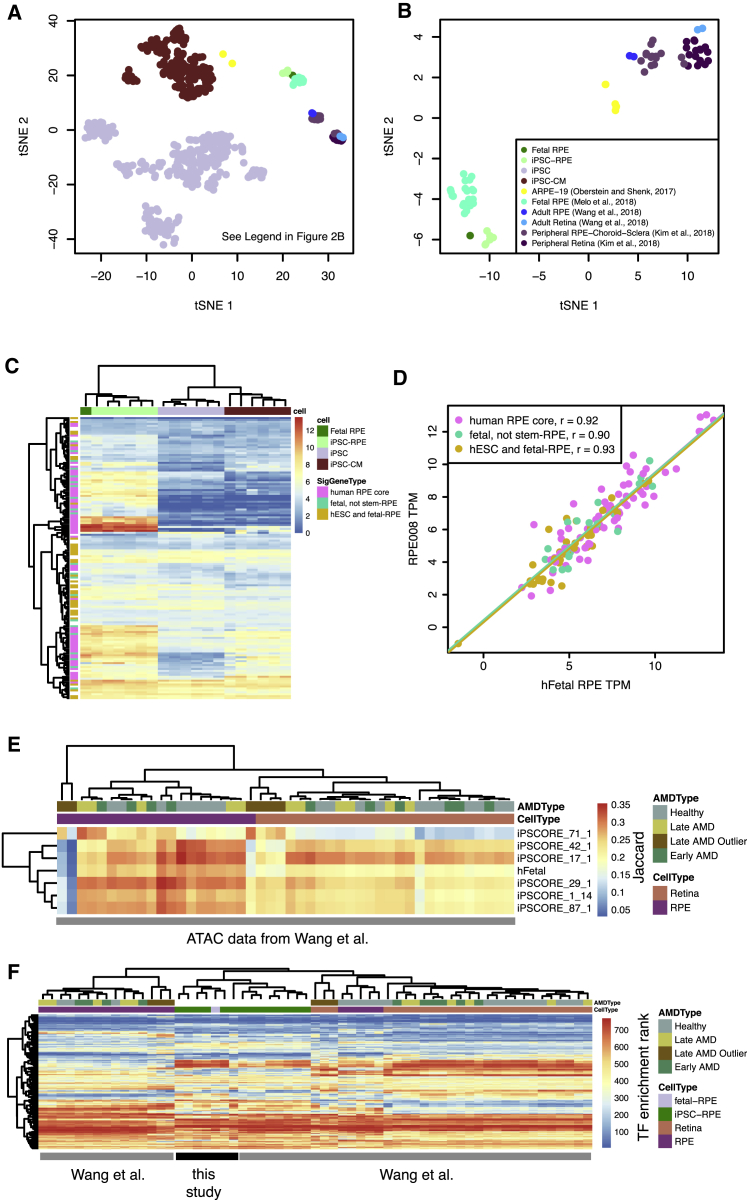
Gene Expression and Chromatin Accessibility of iPSC-RPE and Other Eye Samples(A) tSNE plot based on the first 30 principal components of RNA-seq using 10,000 of the most variable genes. Samples include iPSCs, iPSC-CMs, iPSC-RPE, and fetal RPE data generated for this paper, and RPE and retina samples from external public data sources (see legend in B, inset).(B) tSNE plot based on the first 30 principal components of RNA-seq using 10,000 of the most variable genes. In this case only samples related to RPE and retina are included.(C) Heatmap showing expression levels of RPE signature genes (Strunnikova et al., 2010) in fetal RPE, iPSC-RPE, iPSC, and iPSC-derived cardiomyocytes. Genes are labeled by their gene group as annotated in Liao et al. (2010).(D) Scatterplot showing RNA-seq TPM for an iPSC-RPE (iPSCORE_1_14) compared with the fetal RPE sample for RPE signature genes. Points are color coded according to their classification in Liao et al. (2010) and lines indicate linear regression best fits.(E) Heatmap showing six iPSCORE iPSC-RPE (iPSCORE_42_1, 17_1, 29_1, 1_14, and 87_1) and human fetal RPE ATAC-seq peaks show stronger Jaccard similarity to native RPE ATAC-seq peaks than retina ATAC-seq peaks from adult eyes with and without AMD (Wang et al., 2018). Columns are color coded according to their AMD type and cell type. Three RPE and three Retina samples from the same subject with late AMD were not similar with respect to the other RPE and Retina samples and were labeled as “Late AMD Outlier.”(F) Heatmap showing similarity of transcription factor (TF) binding site enrichment in ATAC-seq peaks across samples. Color indicates the TF's rank of enrichment within each sample with red indicating stronger enrichment. Columns are color coded according to their AMD type and cell type.See also Figure S1.